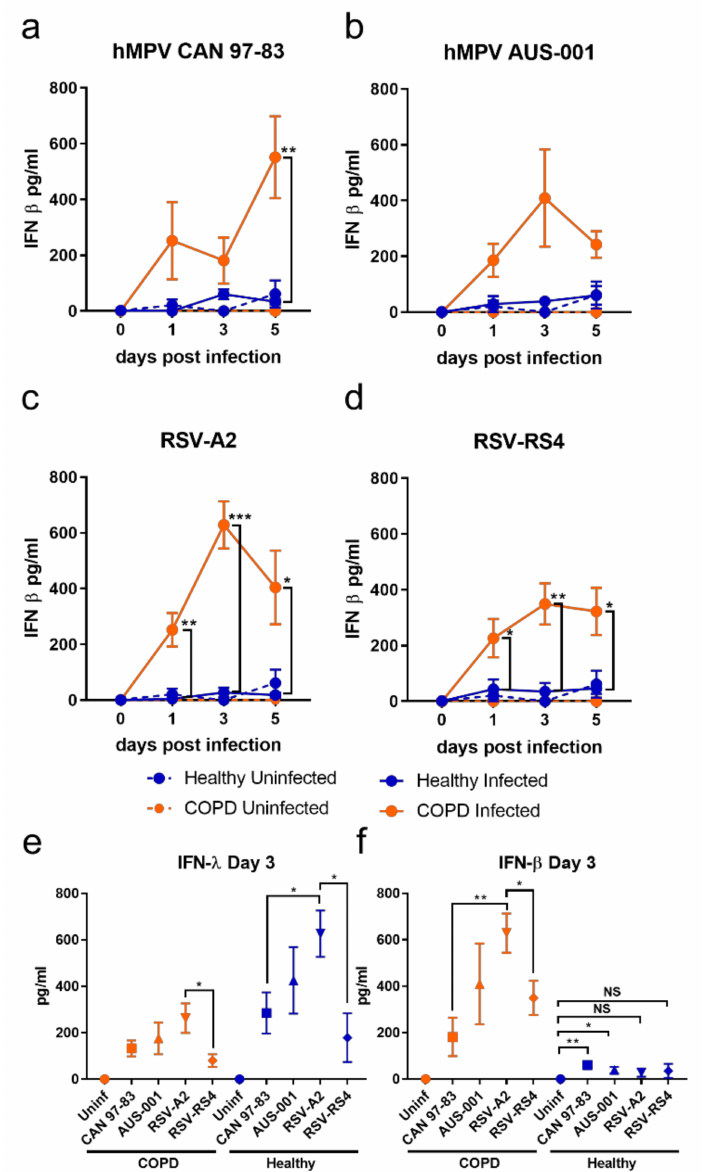
Figure 3. IFN- β production by submerged monolayers of BECs infected with ( a ) CAN 97-83 ( b ) AUS- 001 ( c ) A2 or ( d ) RS4, MOI 0.1. Secreted IFN- β was quantified in cell supernatant at day 0, 1, 3, and 5 post-infection by AlphaLISA. The symbols represent the mean ± SEM. n = 5 for both COPD and healthy groups. Unpaired t -tests show statistical significance, * denotes p < 0.05 for COPD group compared to the healthy group. ( e ) IFN- λ and ( f ) IFN- β data for day 3 post-infection were extracted for comparison of production amongst viruses. Unpaired t -tests show statistical significance, * denotes p < 0.05, ** denotes p < 0.01, *** p <